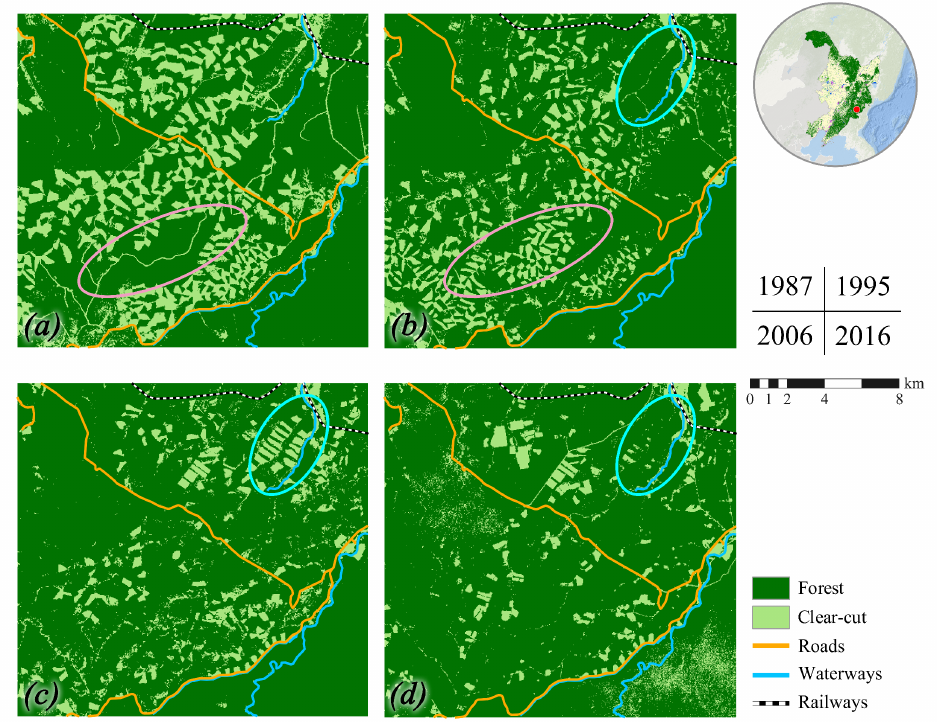
Figure 6. Forest logging activities captured by the map series. The four subfigures show the land cover at the same place for year 1987 ( a ), 1995 ( b ), 2006 ( c ), 2016 ( d ). Note the new clear-cuts and forest recovery in the